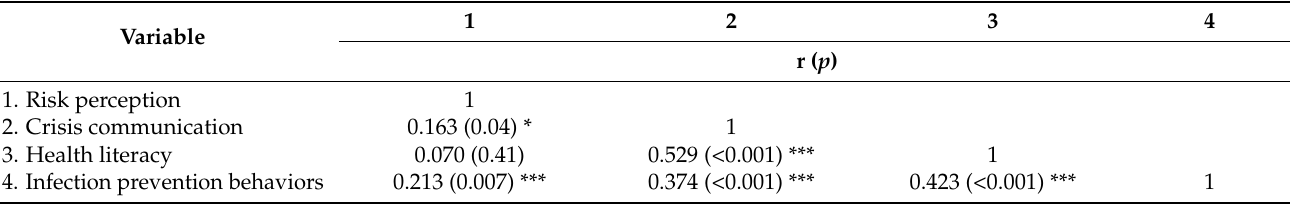
Table 5. Correlations among COVID-19-related variables (N =